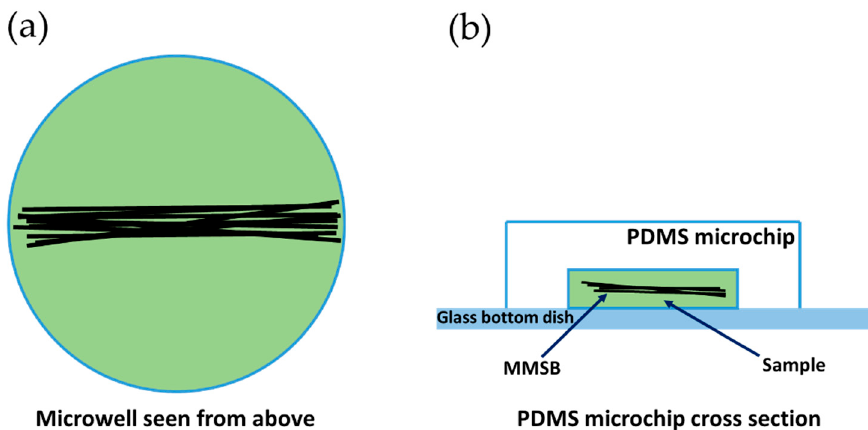
Figure 6. Schematic diagram after applying the external rotating magnetic field to the powder enclosed in the PDMS microwell. ( a ) A view of the PDMS microwell from directly above. ( b ) A view of the PDMS microwell from the side.